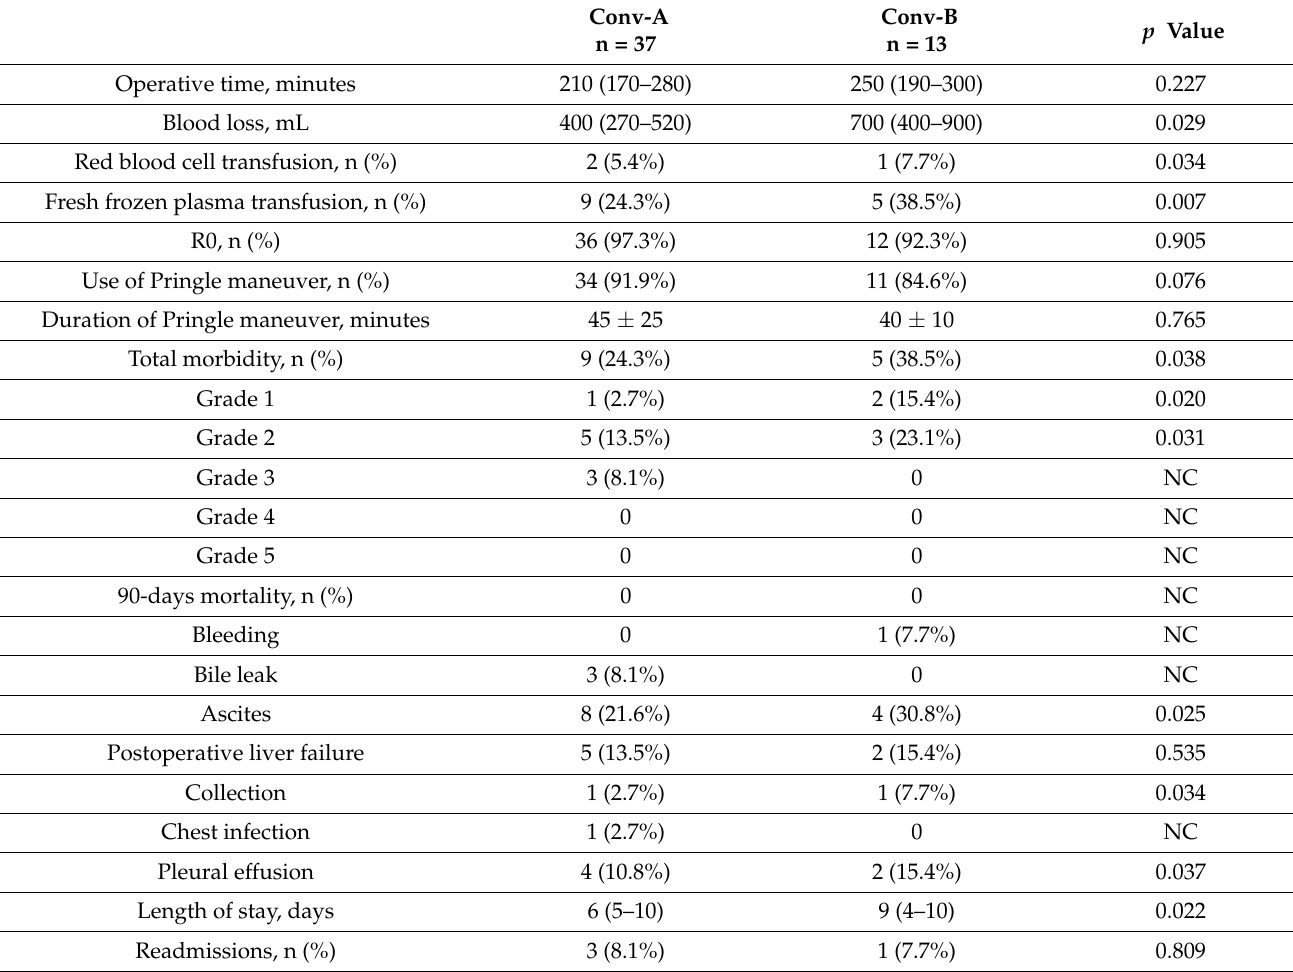
Table 7. Results of converted MILRs for HCC: Child A versus converted MILRs in advanced cirrhosis (Child B and Child A/B with portal hypertension) patients for intermediate/expert/advanced Iwate difficulty level